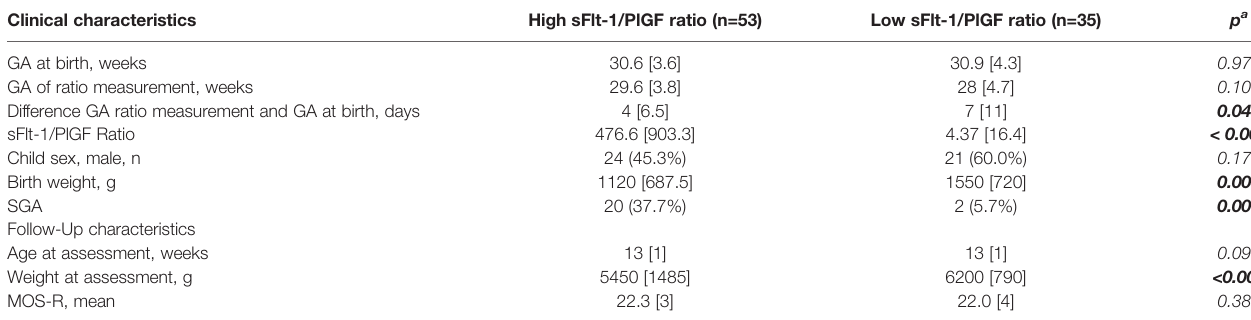
TABLE 3 | Baseline patient